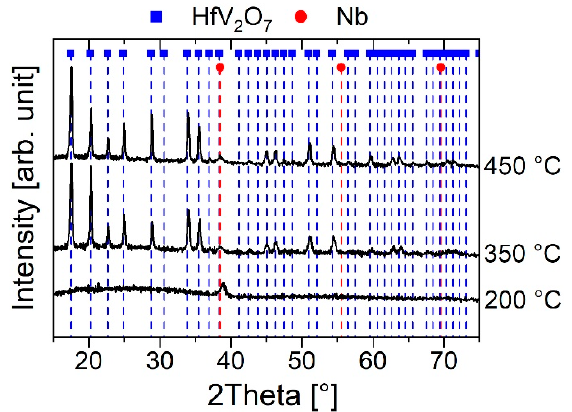
Figure 3. Di ff ractograms of HfV 2 O 7 thin films deposited at di ff erent temperatures. The films were Figure 3. Diffractograms of HfV 2 O 7 thin films deposited at different temperatures. The films were capped with a ~10 nm thick Nb capped with a ~10 nm thick Nb layer.